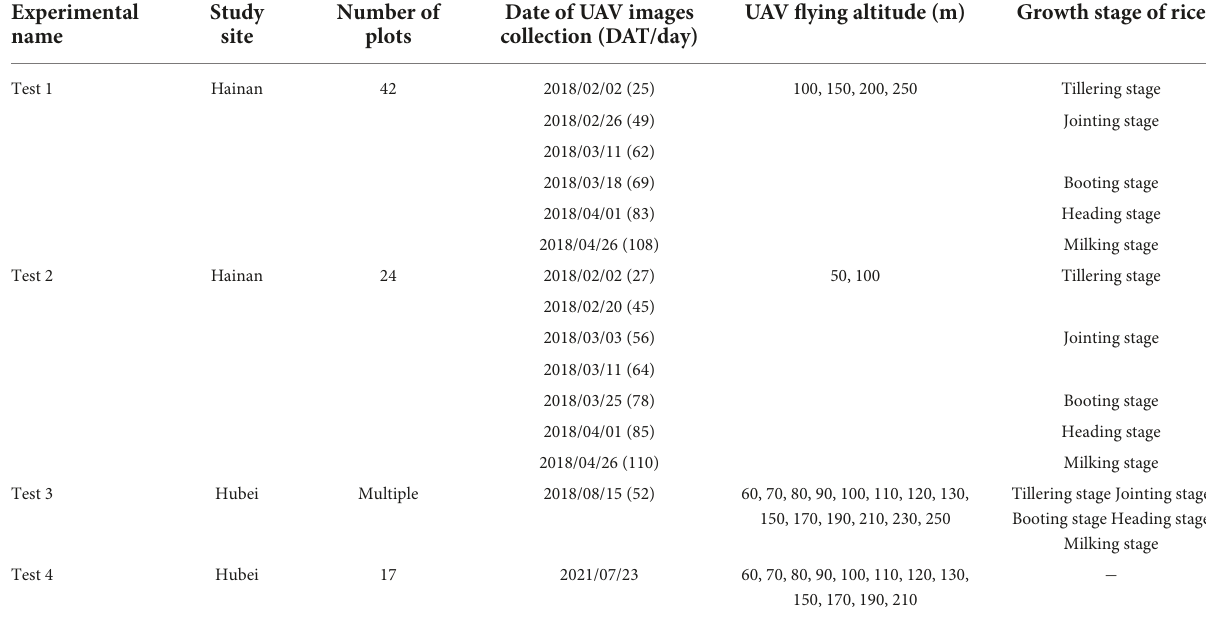
TABLE 1 The details of multispectral images for four experiments in Hubei and Hainan